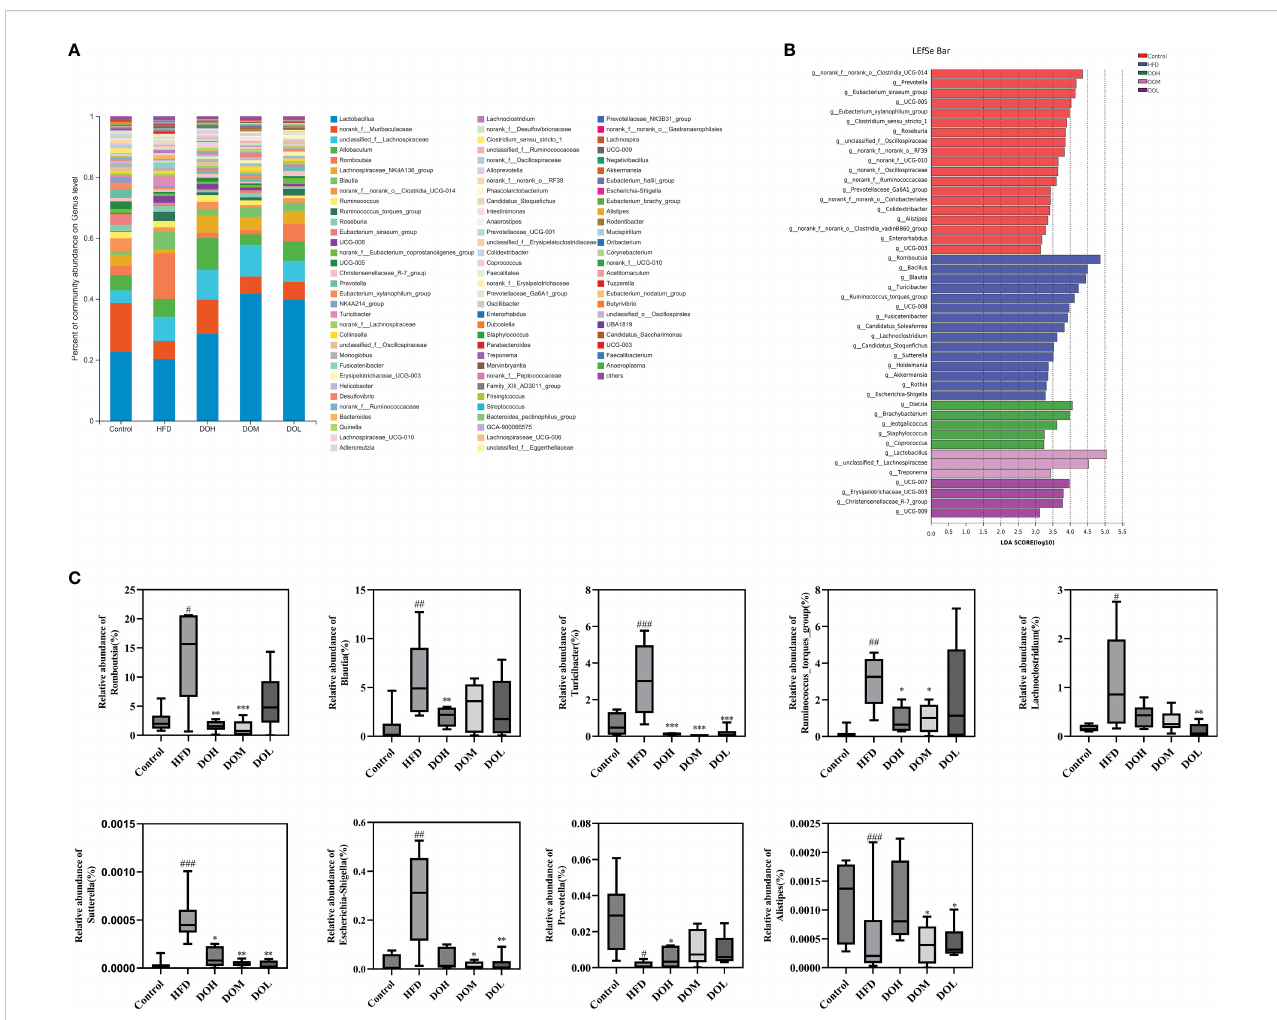
FIGURE 5 DO treatment modulated the composition of the gut microbiome at the genus level. (A) Community abundance at the genus level (%); (B) LEfSe of the gut microbiota at the genus level; (C) relative abundances of Romboutsia , Blautia, Turicibacter, Ruminococcus_torques_group, Lachnoclostridium, Sutterella, Escherichia-Shigella, Prevotella , and Alistipe . Data are expressed as the mean ± SD (n=6). # p < 0.05, ## p < 0.01, ### p < 0.001 vs. the Control group; * p < 0.05, ** p < 0.01, *** p < 0.001 vs. the HFD